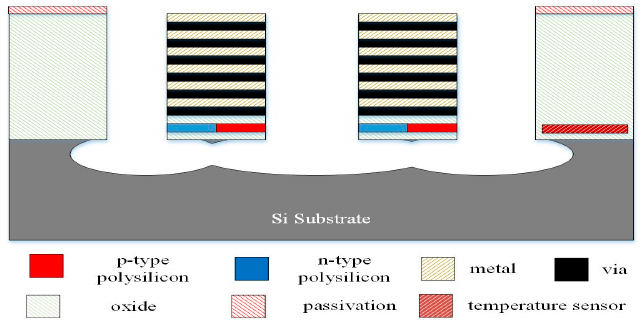
Figure 8. Cross section of the TEMH after etching of the silicon substrate.